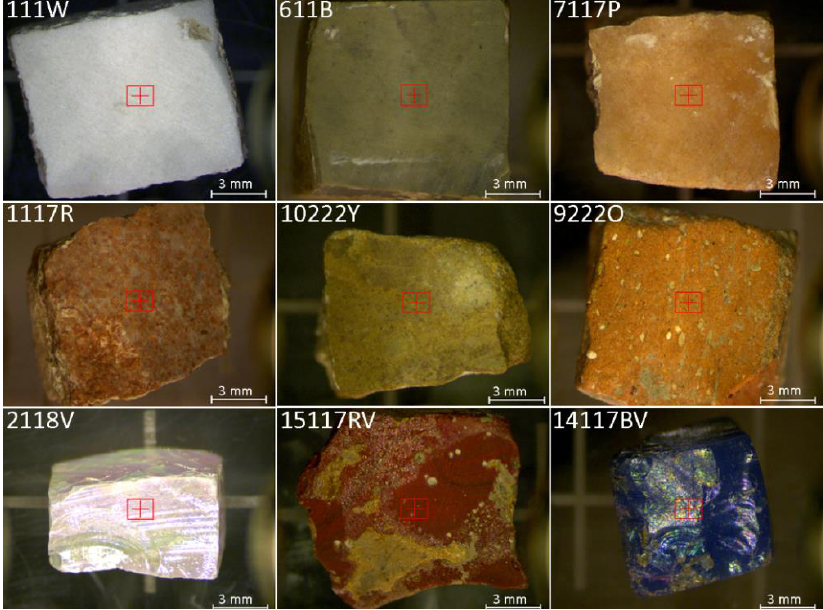
Figure 5. Representative selection of the studied tesserae showing samples ’ colors and materials. The nomenclature used indicates nº sample/ domus /room/color; in which the final